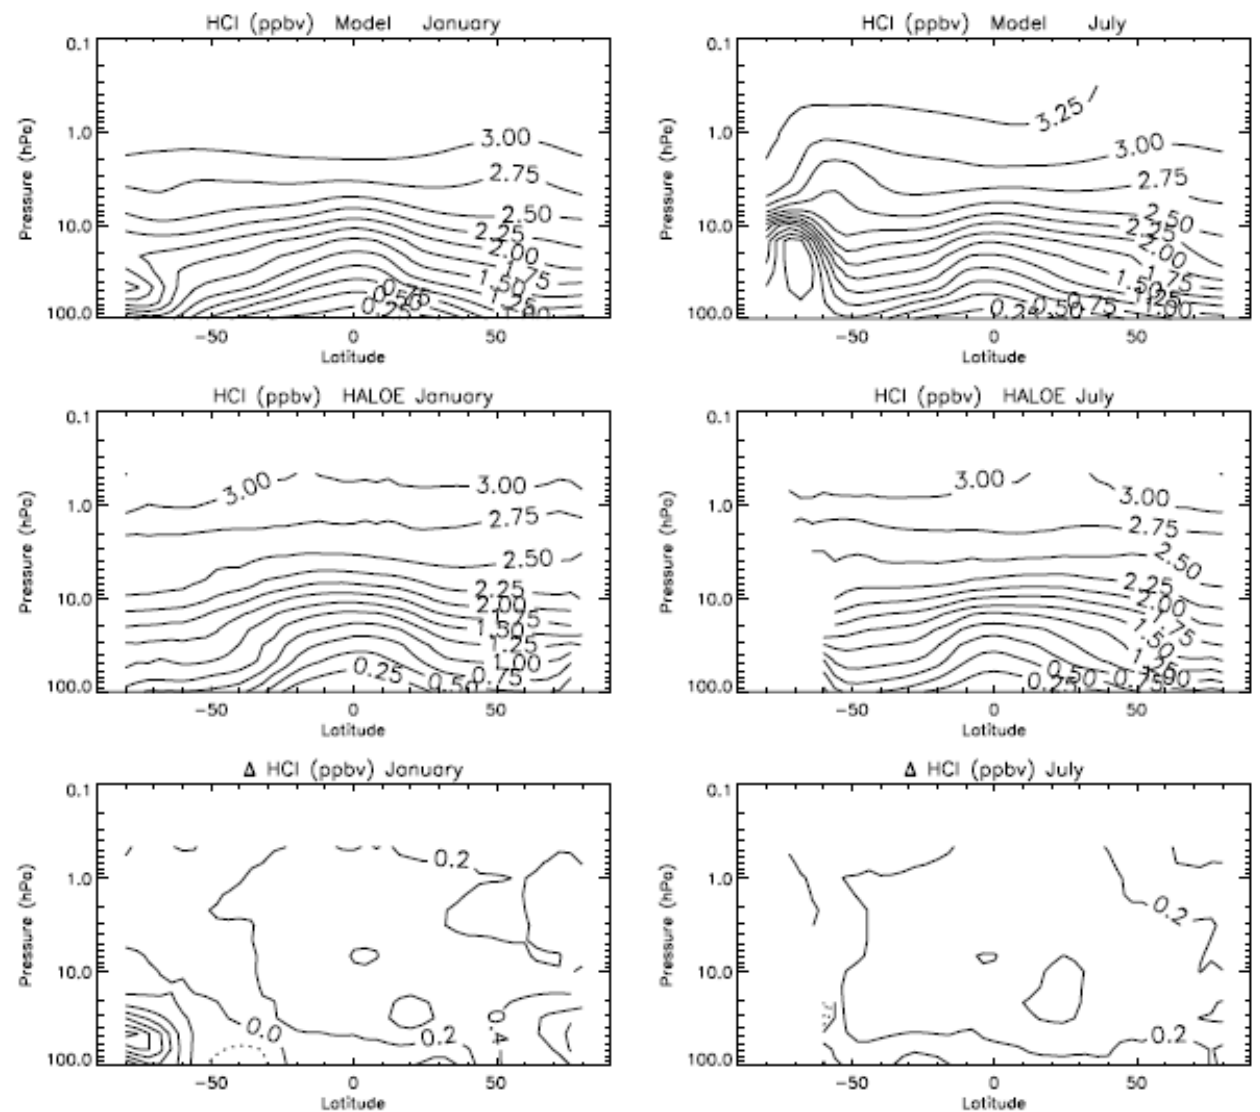
Fig. 12. January and July zonal mean distributions of HCL mixing ratios (ppbv) simulated by the model for the period 1991–1997 (top) and Figure 12: January and July zonal mean distributions of HCL mixing ratios (ppbv) 2 observed by HALOE (middle) and their differences (contours in steps of simulated by the model for the period 1991-1997 (top) and observed by HALOE 3 (middle) and their differences (contours in steps of 0.2 ppbv). 4